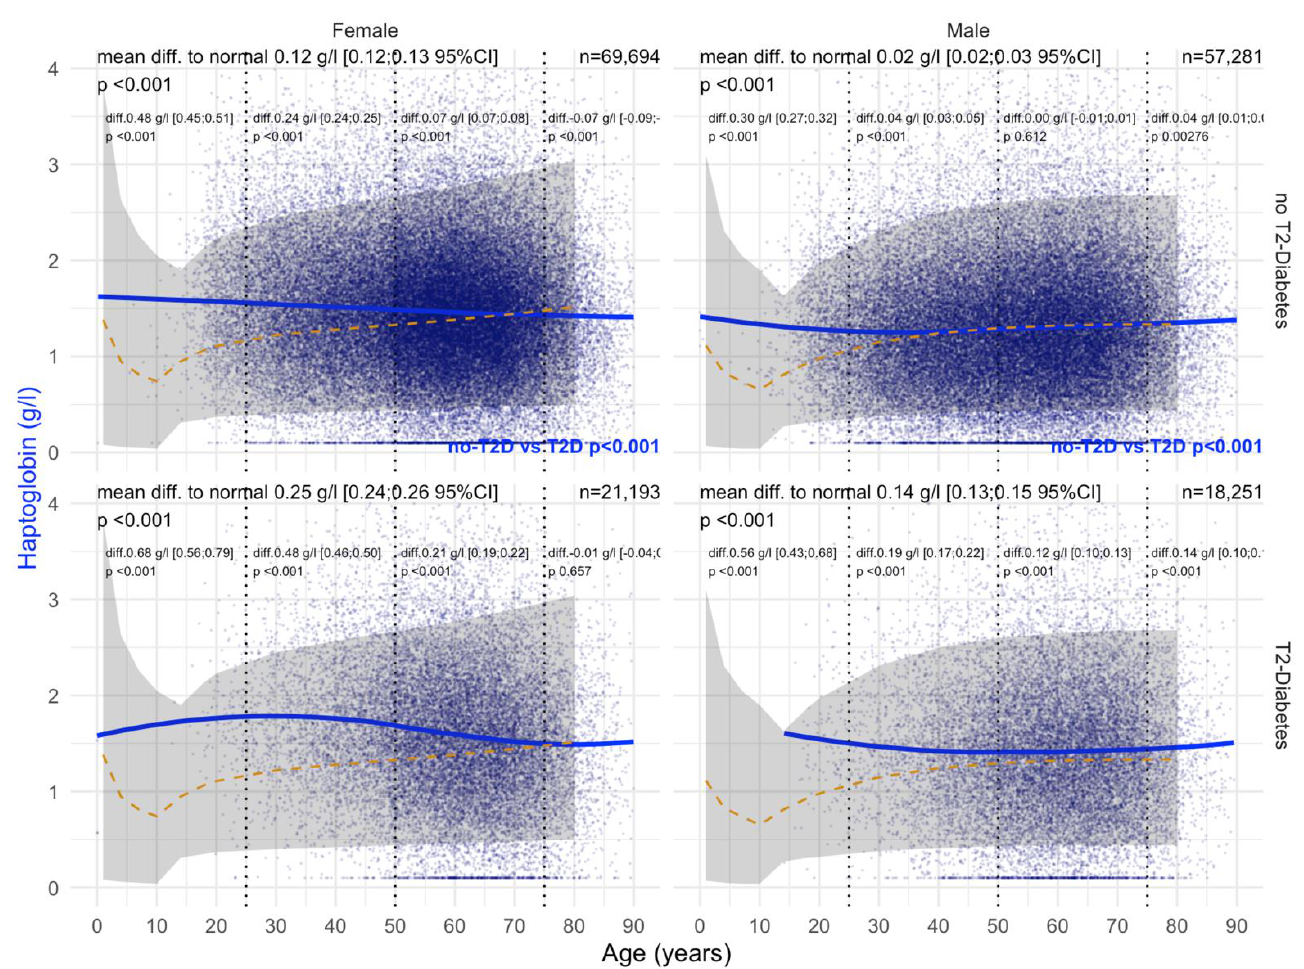
Figure 17. Haptoglobin levels during the COVID-19 pandemic. Impact of T2DM on Hapto concentration during SARS-CoV-2 pandemic in “NAFLD-Serum” patients followed for metabolic liver risk (n = 173,246). Normal serum means values according to age and sex (dashed–orange lines), with 95% confidence intervals (gray ribbon). Three vertical–dotted lines mark the four age groups (before 25, between 25 and 50, between 50 and 75, and above 75 years old). The blue curve is a Loess regression of the median of Hapto values. For each age group, the mean difference (%95CI) between the patient protein value and the expected normal value (for age and sex) with its significance p -value is displayed at the top of the figure. The significance between the non-T2DM and T2DM patients is displayed in blue between the 2 panels.